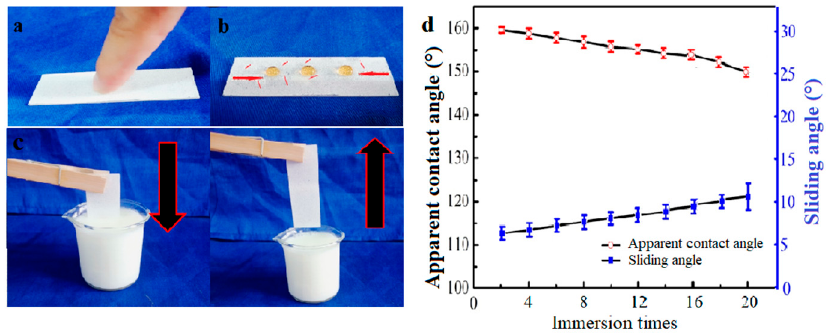
Figure 10. ( a ) The durability test by pressing with a finger; ( b ) photograph of water droplets after touching; ( c ) one-time immersion in yogurt and ( d ) the change of apparent contact angle and sliding angle of the treated surface plotted against immersion times in yogurt.